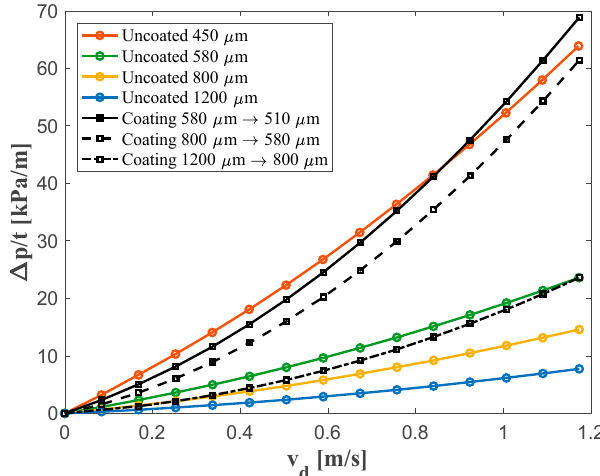
Figure 6. Comparison of measured pressure drop ∆ p along uncoated and coated metal foams normalized with respect to thickness t for different flow velocities v d . Color coding as in Figure 4.